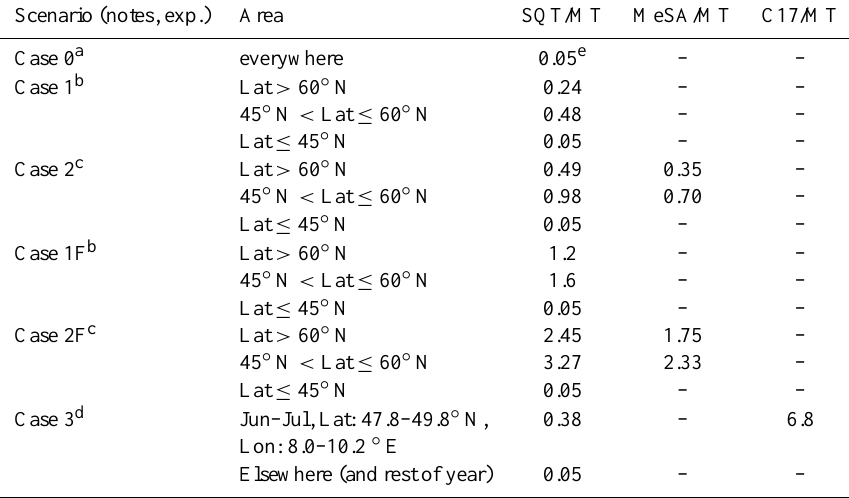
Table 1. Biotic stress-induced emissions (SIE) of sesquiterpenes (SQT), methyl salicylate (MeSA) and unsaturated C 17 BVOC (C17) in the different model scenarios. The SIE are expressed as fractions of the daytime model emissions of monoterpenes (MT). Scenario (notes,